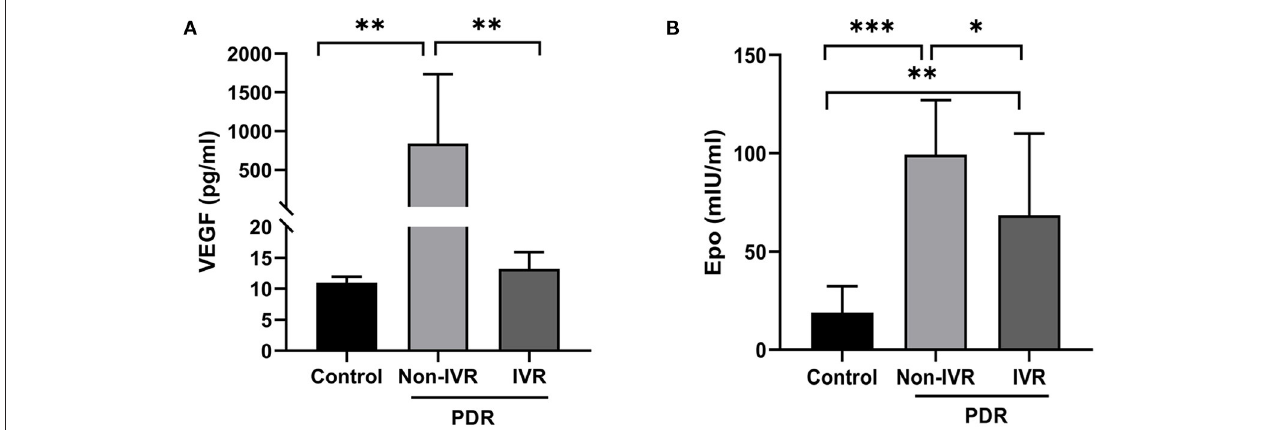
FIGURE 1 | Vitreous concentration of VEGF (A) and EPO (B) in the control and PDR group. * P < 0.05; ** P < 0.01; *** P < 0.0001. PDR, proliferative diabetic retinopathy; IVR, intravitreal ranibizumab.